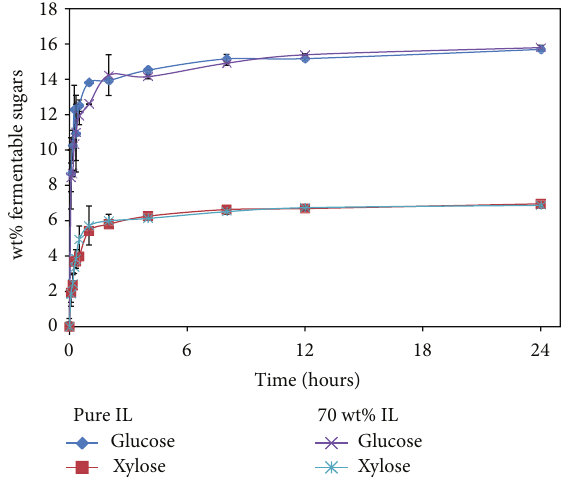
Figure 2: Effect of ionic liquid concentration on hydrolysis kinetics of safflower whole seed, using pure and 70 wt% [C2mim][Ac] at 120 ∘